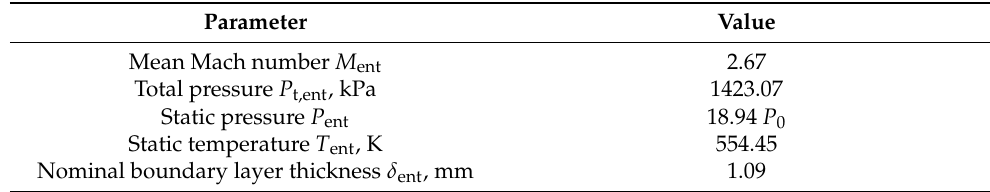
Table 2. Incoming flow conditions at the